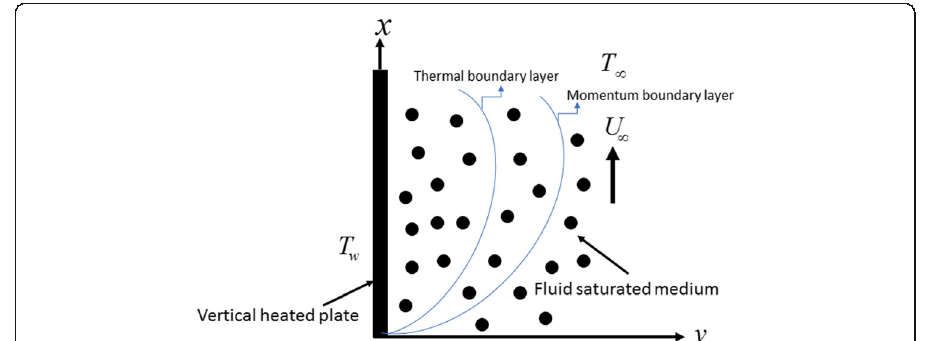
Fig. 1 Coordinate system of fluid